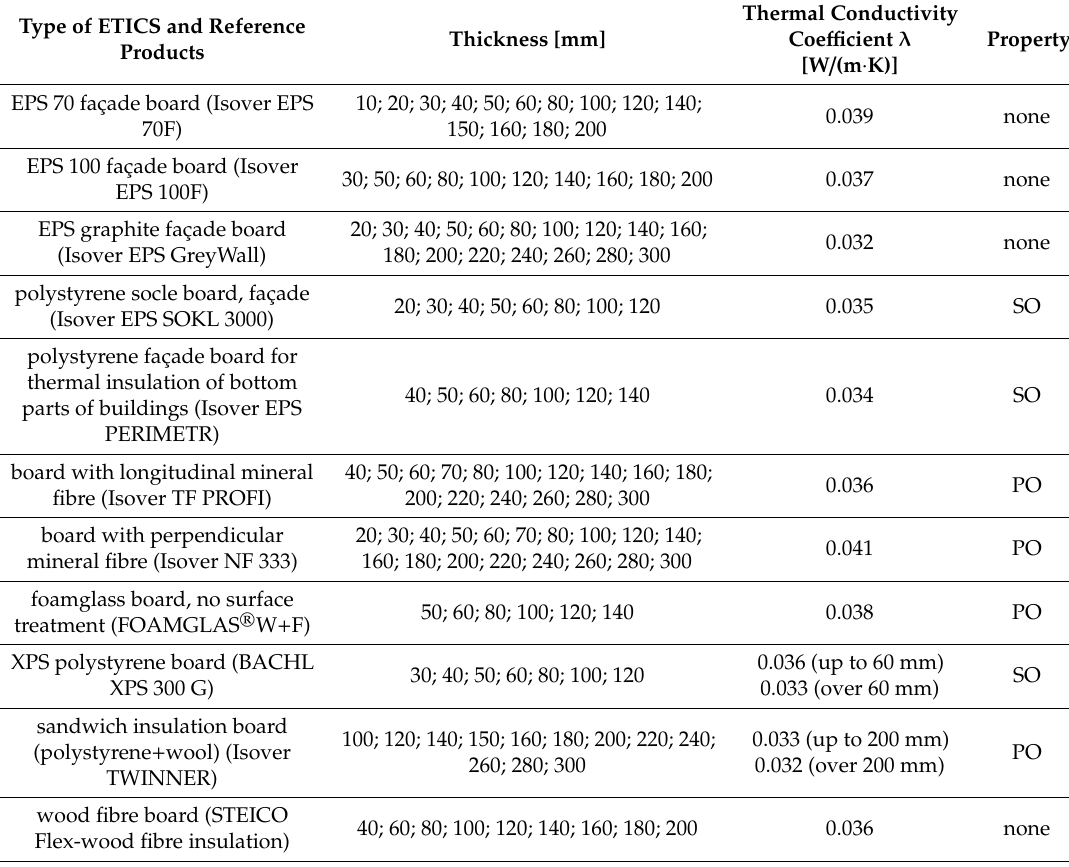
Table 2. The list of individual types of ETICS with their possible thickness values, thermal conductivity coe ffi cient and indication of special properties (none = no special properties; SO = meant for the socle area; PO = fire resistant)